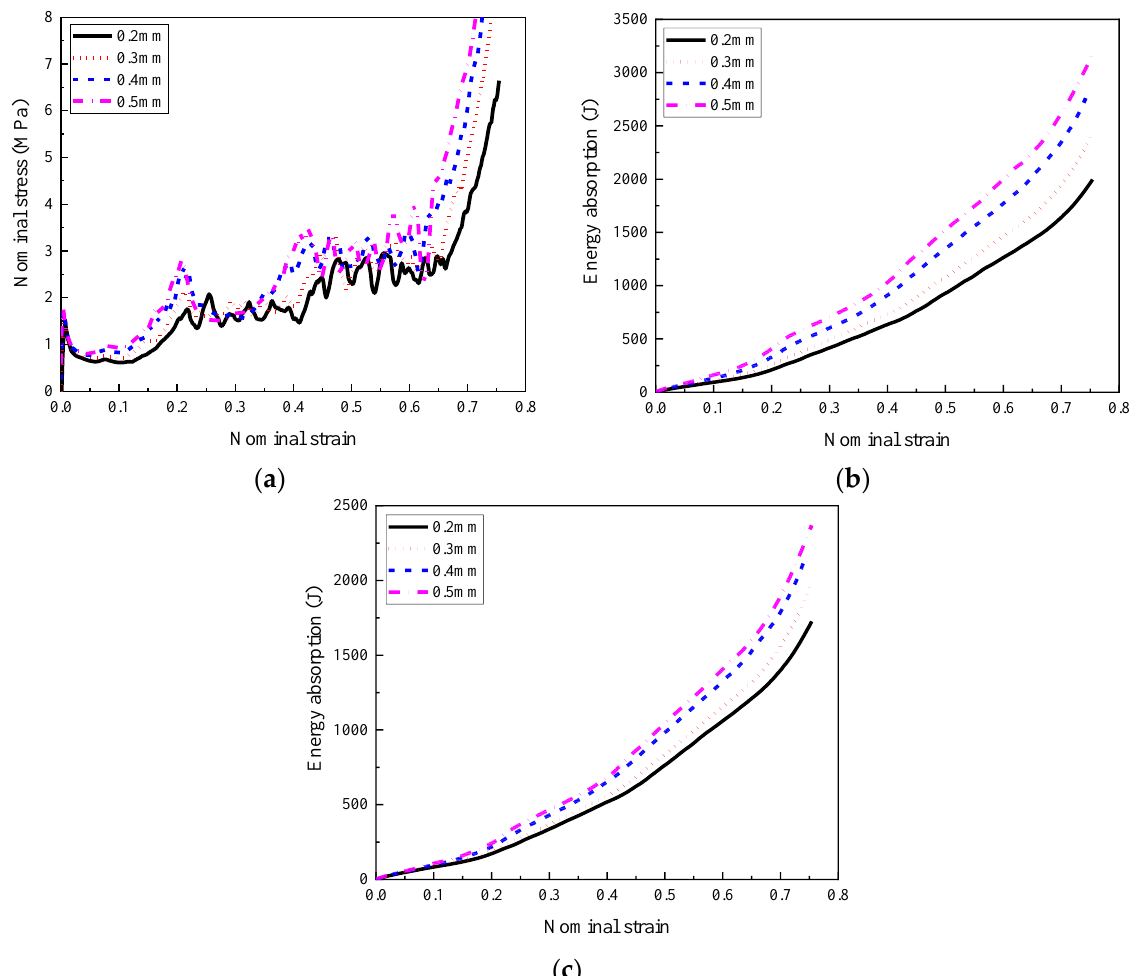
Figure 22. The stress – strain relationships and energy absorption of the composite ( ρ = 408:575:848) with different cell-wall thicknesses (1 m/s): ( a ) stress – strain relationships; ( b ) energy absorption of the composite; ( c ) energy absorption of the foam concrete.